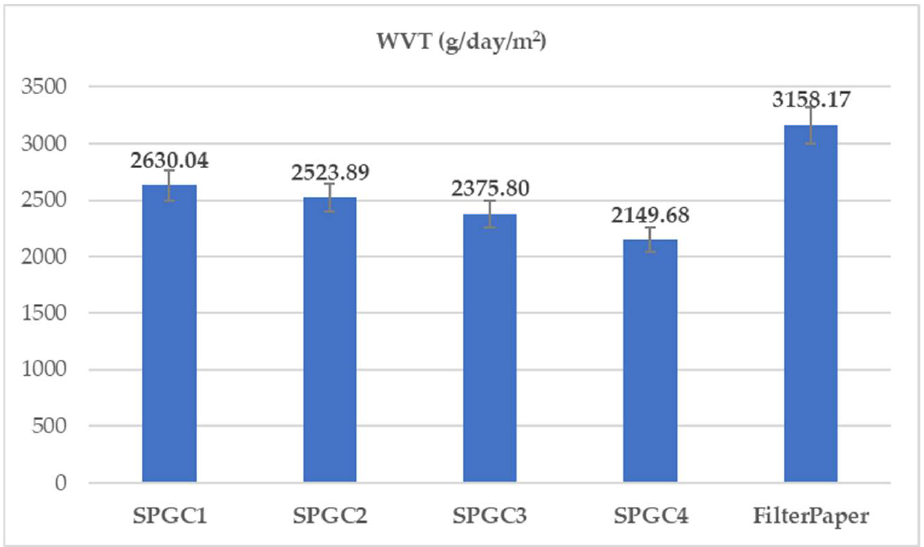
Figure 5. Water vapor transmission rate for starch-based wound-dressing films.